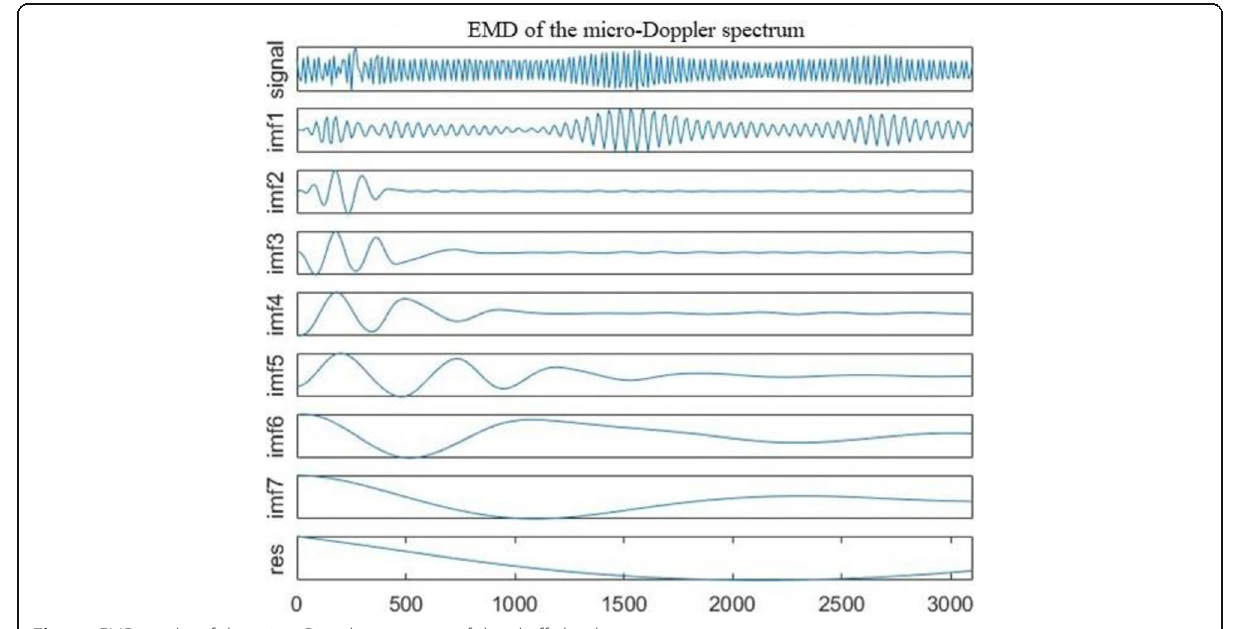
Fig. 15 EMD results of the micro-Doppler spectrum of the chaff cloud